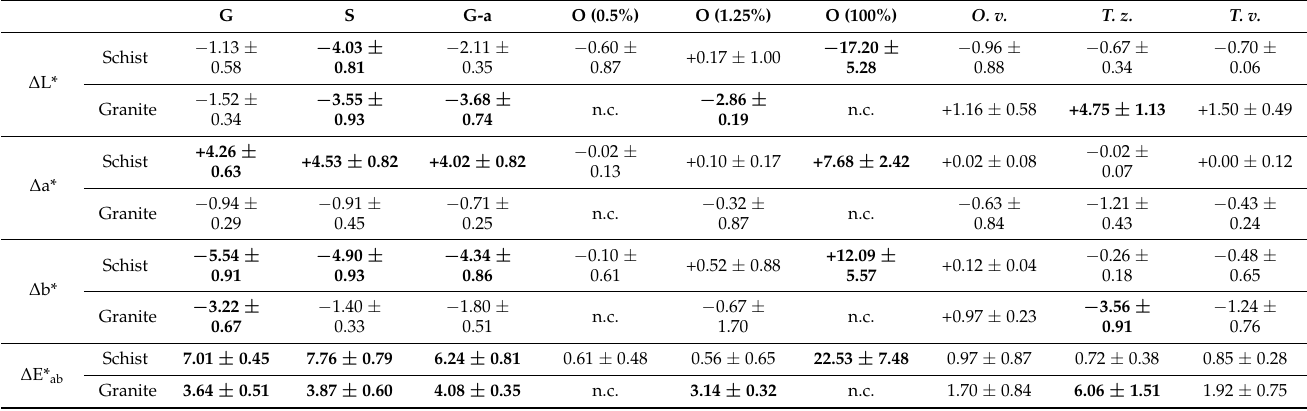
Table 6. Partial changes in lightness ( ∆ L*), the green–red colour component ( ∆ a*) and the blue–yellow colour component ( ∆ b*), and total colour change ( ∆ E* ab ). According to the values obtained and taking a threshold of 3 CIELAB units, perceptible changes ( ≥ 3 CIELAB units) are indicated in bold. n.c.: not considered. G S G-a O (0.5%) O (1.25%) O (100%) O.